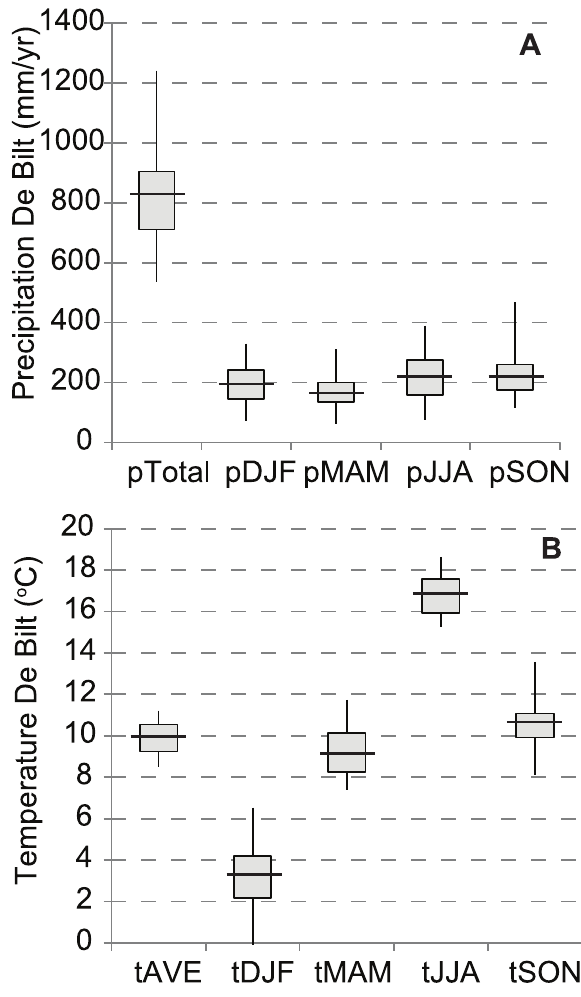
Figure 2. Annual and seasonal variability of the meteorological data from De Bilt. Values are expressed as the upper and lower quartiles, median, and minimum and maximum values of (a) cumulative precipitation and (b) mean temperature for AD 1969–2012.